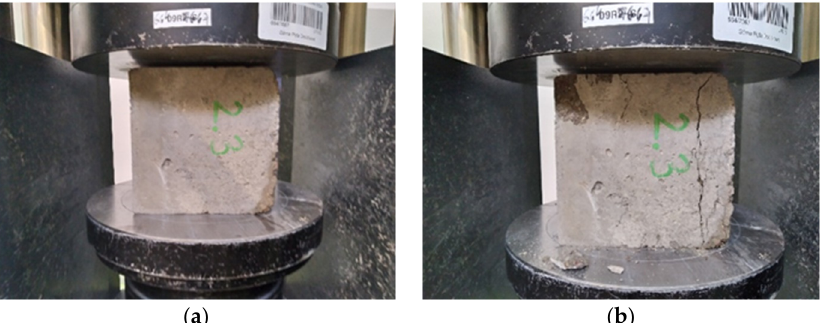
Figure 10. Concrete with micro-nano ozone bubbles before ( a ) and after compressive strength testing ( b ) following 150 F-T cycles.